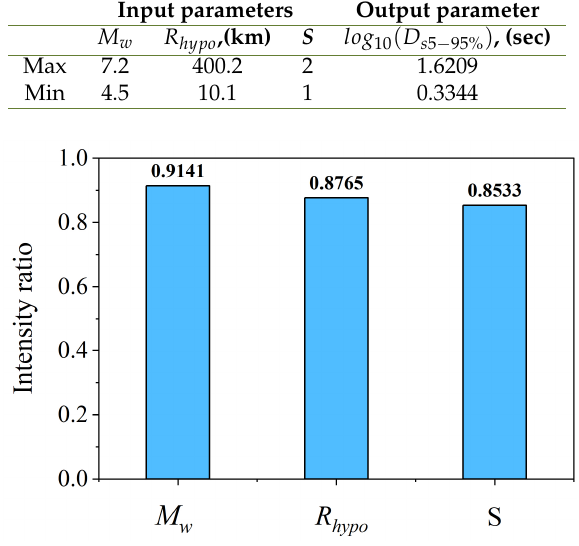
Fig. 9. Input sensitivity analysis for log 10 D s 5 − 95%